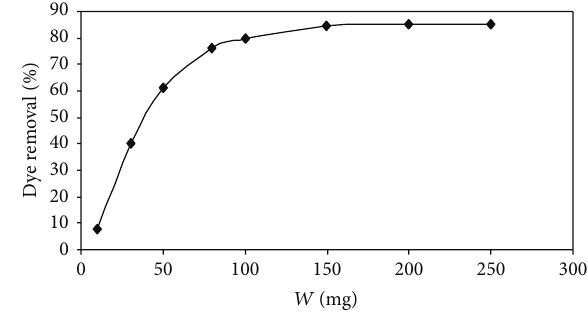
Figure 7: Effect of adsorbent dose on the adsorption of AB25 onto IJSP. Conditions as in Figure 6 except dose and pH =